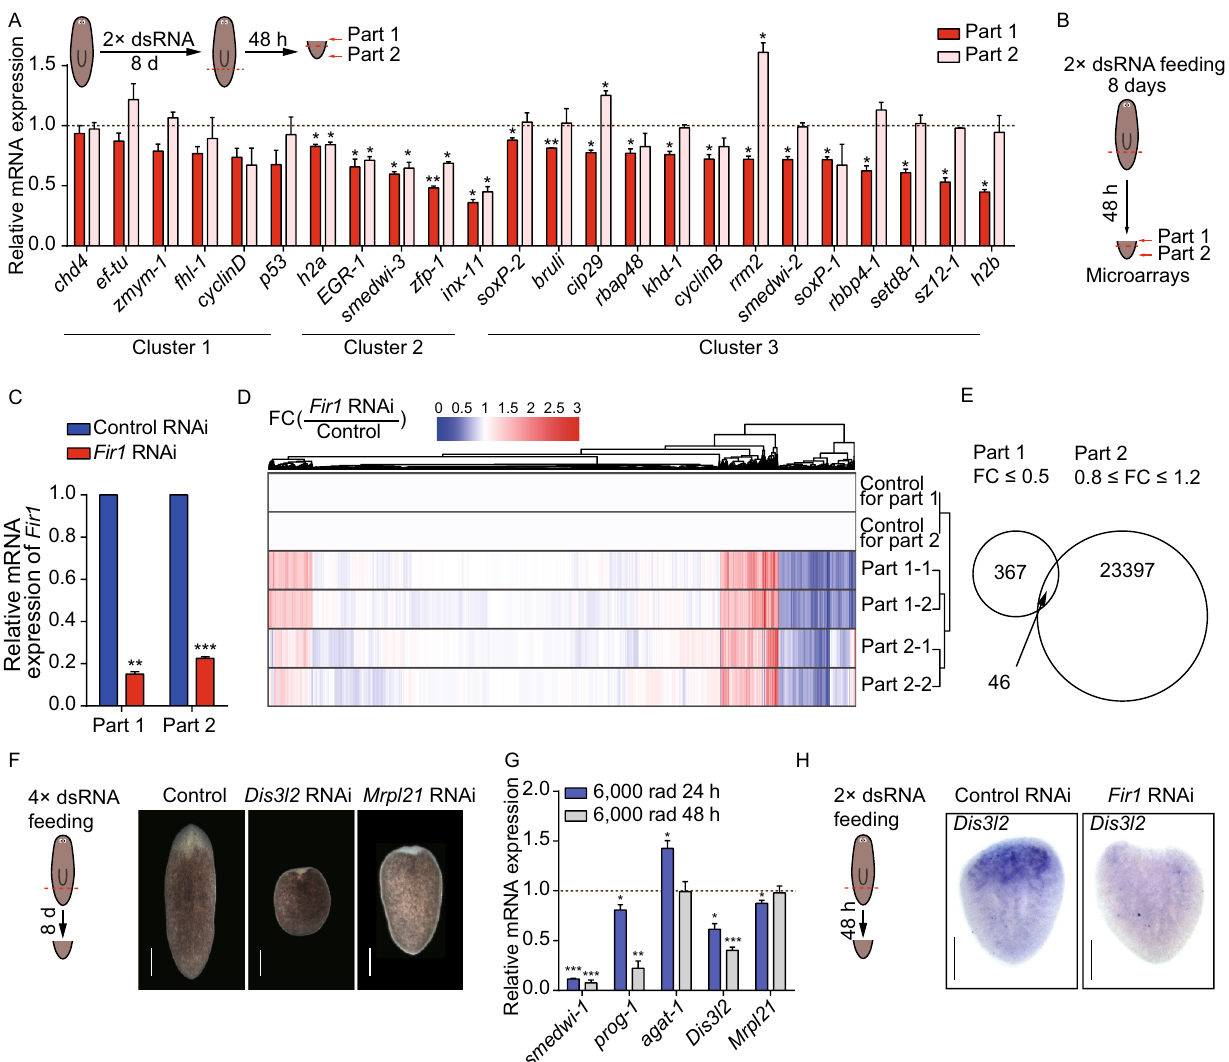
Figure 4. Analysis of Fir1 downstream genes. (A) qRT-PCR showing the relative mRNA expression of several known neoblast regulators following Fir1 (RNAi). Shown are averages of three independent experiments; error bars = SEM; ** equals P < 0.001; *** equals P < 0.0001; signi fi cance determined with Student ’ s t test. (B) Schematic of strategy for expression pro fi ling. (C) qRT-PCR showing that relative expression level of Fir1 decreased dramatically in part 1 and part 2 regions of Fir1 (RNAi) tail pieces. Shown are averages of three independent experiments; error bars = SEM; ** equals P < 0.001; *** equals P < 0.0001; signi fi cance determined with Student ’ s t test. (D) Heat map of microarrays. Fold change ( Fir1 RNAi/control); (red) up, (blue) down; P < 0.05. (E) Venn diagram of genes down-regulated in the part 1 region and invariable in the part 2 region in Fir1 (RNAi) tail piece. (F) RNAi knockdown of two candidates ( Dis3l2 and Mrpl21 ) respectively, tail pieces hardly regenerate blastemas ( n = 6). To increase the RNAi ef fi ciency, we chose 4× dsRNA feedings for the two genes. The animals were amputated behind the pharynx at the day after the fourth dsRNA feeding, and the tail pieces were imaged 8 days post-amputation. Scale bars, 200 μ m. (G) Relative expression levels of smedwi-1 , prog-1 , agat-1 , Dis3l2 and Mrpl21 mRNA in animals after 6,000 rads irradiation exposure. Error bars represent SEM; Student ’ s t test: * equals P < 0.05, ** equals P < 0.001, *** equals P < 0.0001. (H) Colorimetric WISH of Fir1 (RNAi) tail pieces 48 h post-amputation for Dis3l2 . For each condition, n = 10 animals. Scale bars, 200 μ